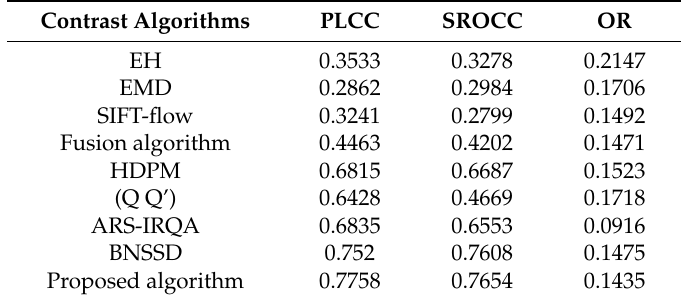
Table 3. Comparison among the proposed method and other methods in the MIT